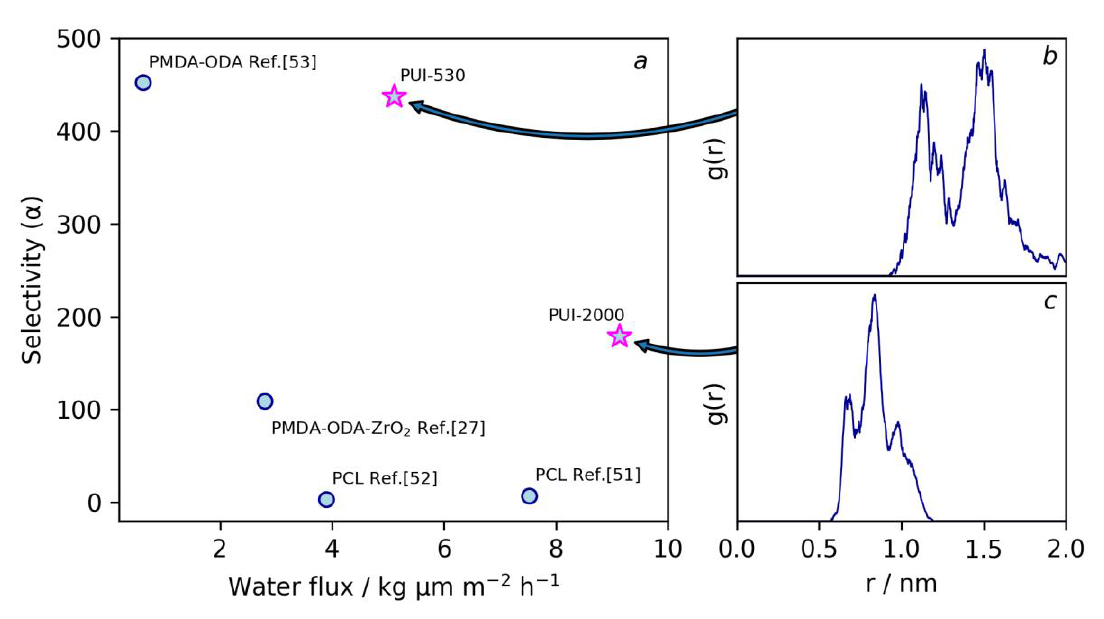
Figure 8. Performance of PUI-530 and PUI-2000 membranes prepared in this work, compared with membranes based on polycaprolactone and pyromellitic dianhydride (PMDA) in the pervaporation dehydration of water/alcohol mixtures ( a ), radial distribution function of distance between C2 carbons of m -phenylenediamine rings for PUI-530 ( b ) and PUI-2000 ( c ).